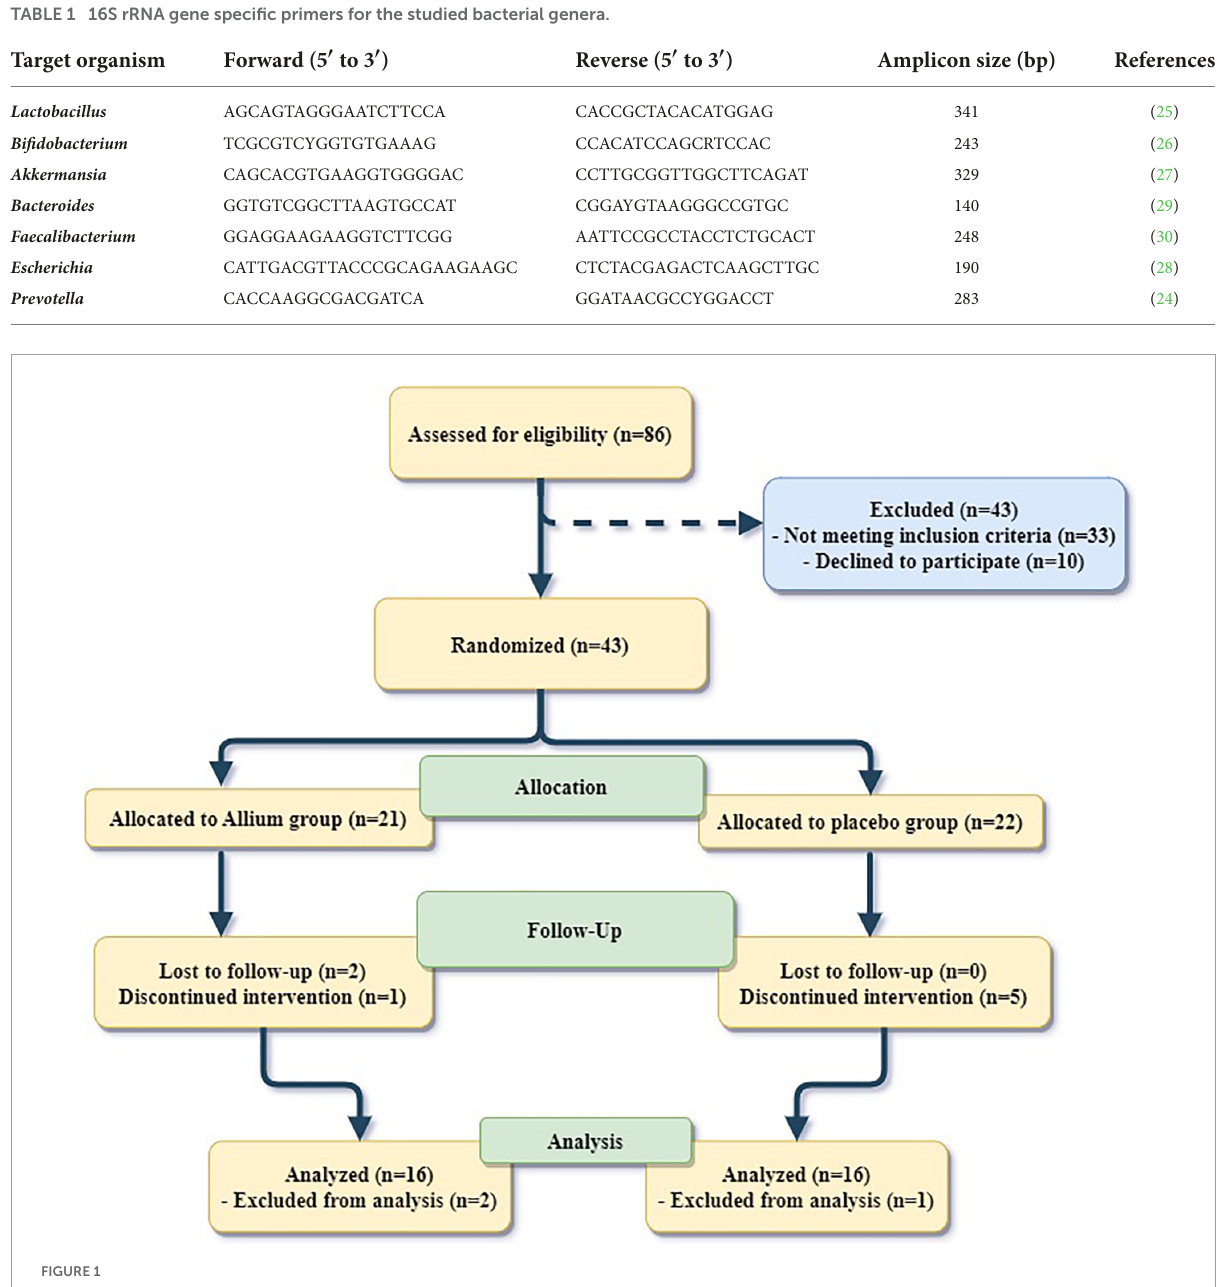
FIGURE1 Flow diagram of the study